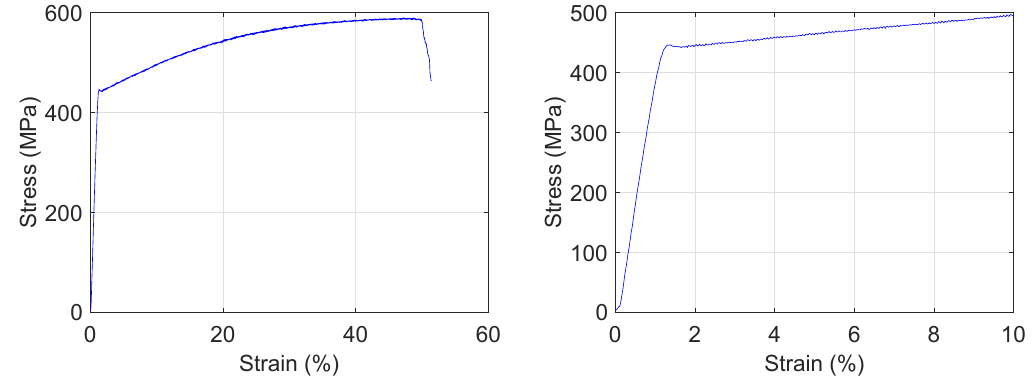
Figure 5. Stress strain curve measured on M270-35A in rolling direction up to the point of fracture ( left ) and below 10% strain ( right ).